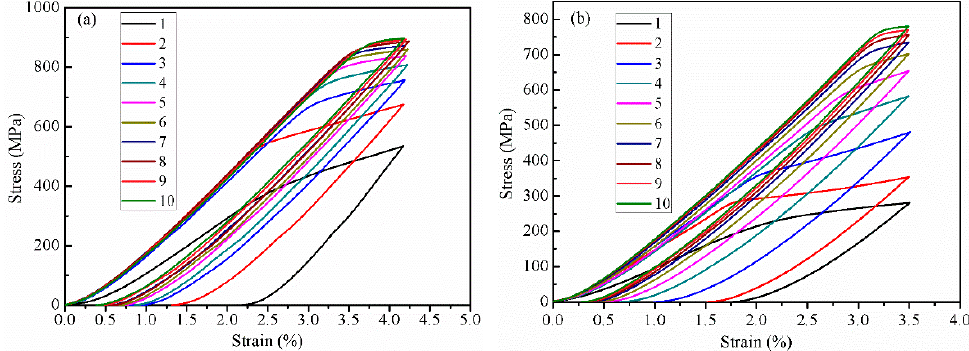
Figure 6. Cyclic loading stress-strain curve of ( a ) Ti 85 Nb 10 Sn 5 and ( b ) Ti 82 Nb 13 Sn 5 alloys.